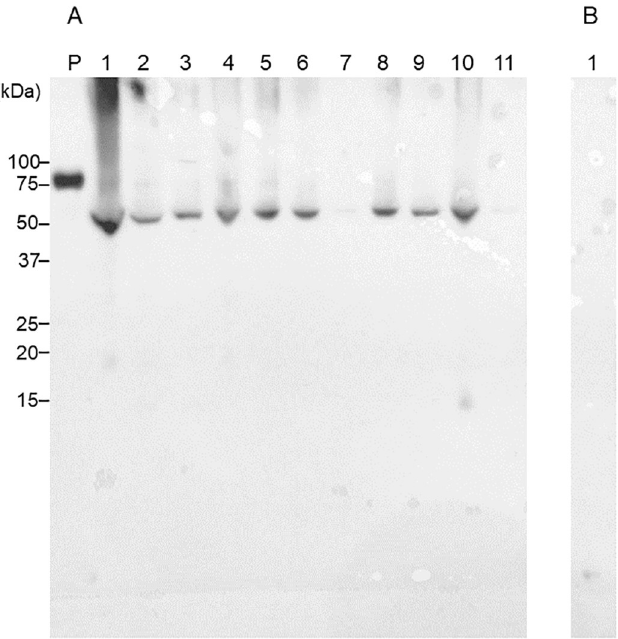
Fig 5. Citrullinated peptides in the saliva of patients with rheumatoid arthritis (RA) and healthy participants. Twelve microliters of saliva per lane were subjected to sodium dodecyl sulfate-polyacrylamide gel electrophoresis. A: Immunostaining was performed using an anti-modified citrulline antibody as the primary antibody and a horseradish peroxidase-labeled goat anti-rabbit IgG antibody as the secondary antibody after the chemical treatment of the membrane. Lane P: positive control (citrullinated thrombomodulin); Lanes 1–5: saliva from patients with RA; Lanes 6–11: saliva from healthy participants. B: Immunostaining was performed using only HRPO-conjugated goat anti- rabbit IgG antibody without primary antibody. Lane 1: Saliva from a healthy